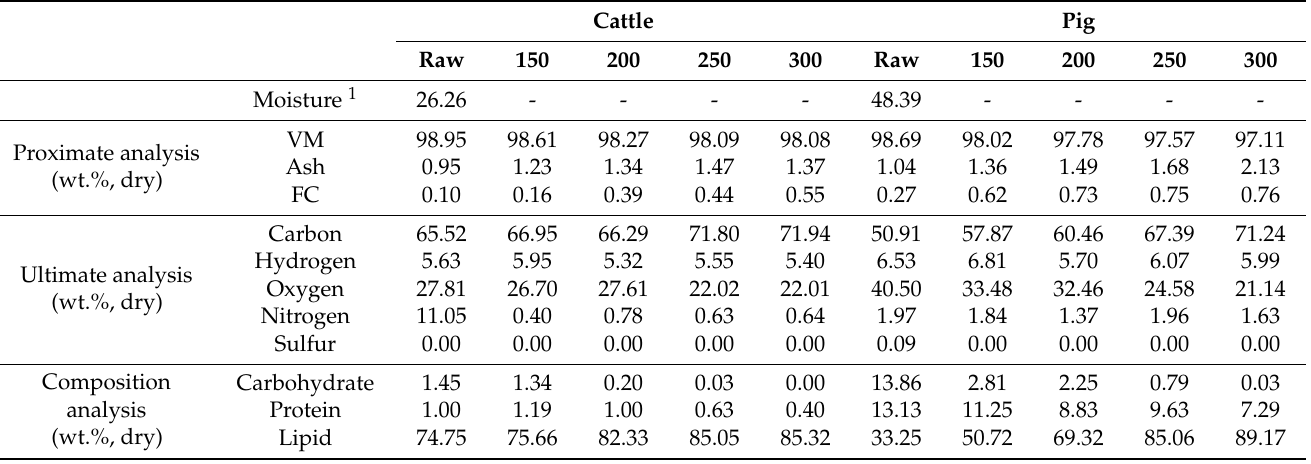
Table 1. Properties of the cattle and pig slaughterhouse wastes (SHWs) and